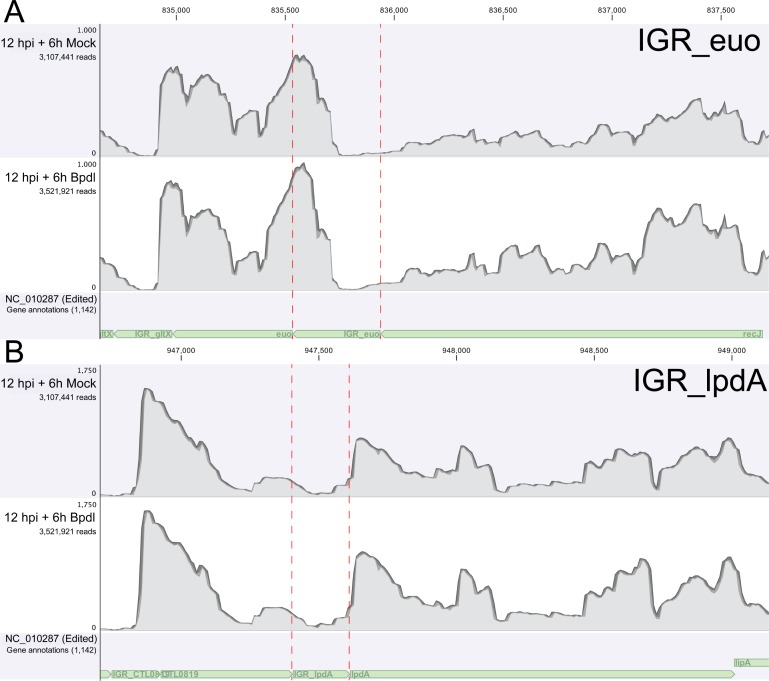
RNA-Sequencing coverage map of reads mapping to the intergenic regions upstream of euo and lpdA.(A) Coverage map for the IGR upstream of euo, a gene that is neither iron-regulated nor YtgR-regulated. (B) Coverage map for the IGR upstream of lpdA, a gene that is iron-regulated but not YtgR-regulated. Neither coverage map indicates an increase in reads mapping to these intergenic regions, suggesting that the effect observed at the trpRBA IGR is specific.